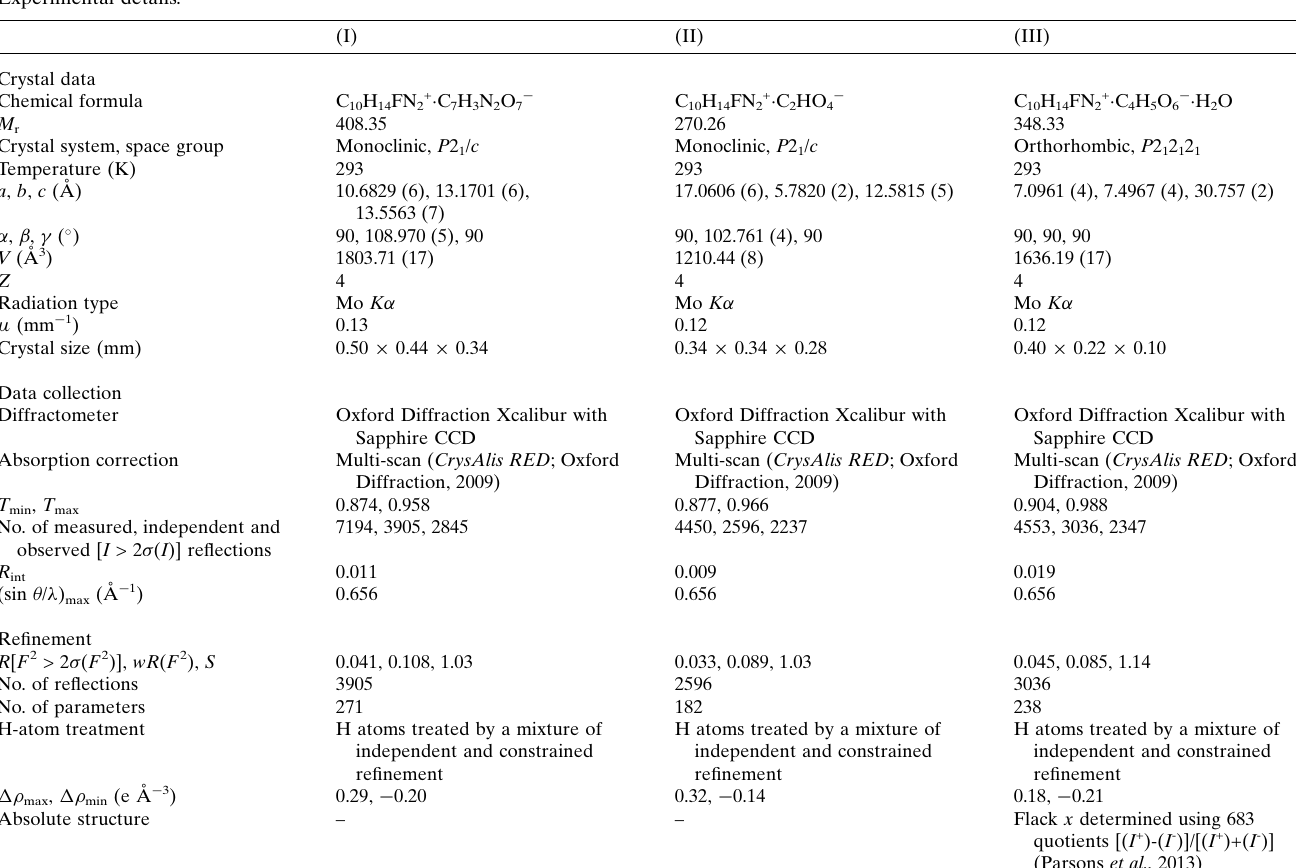
Table 4 Experimental